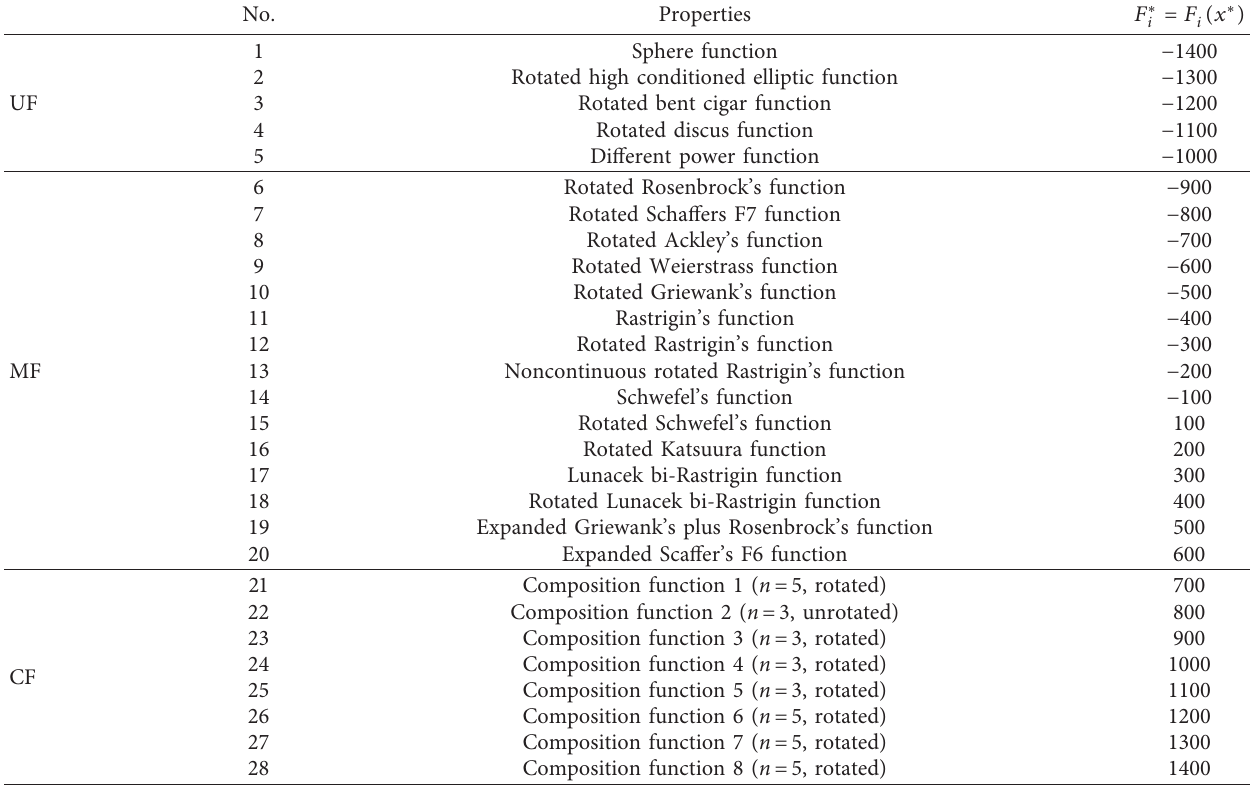
Table 2: The experimental results obtained by DE-1 and DE-5 versus proposed C-DE by solving CEC’13 benchmark functions F n � 10 dimensions. P.